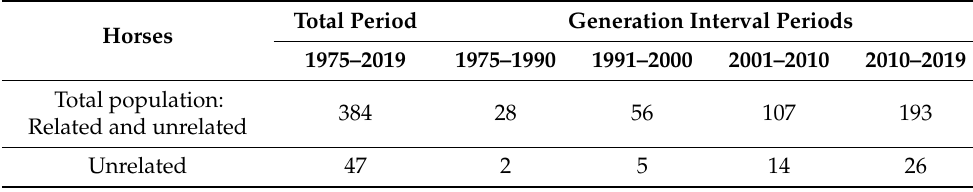
Table 1. Number of samples and generation interval